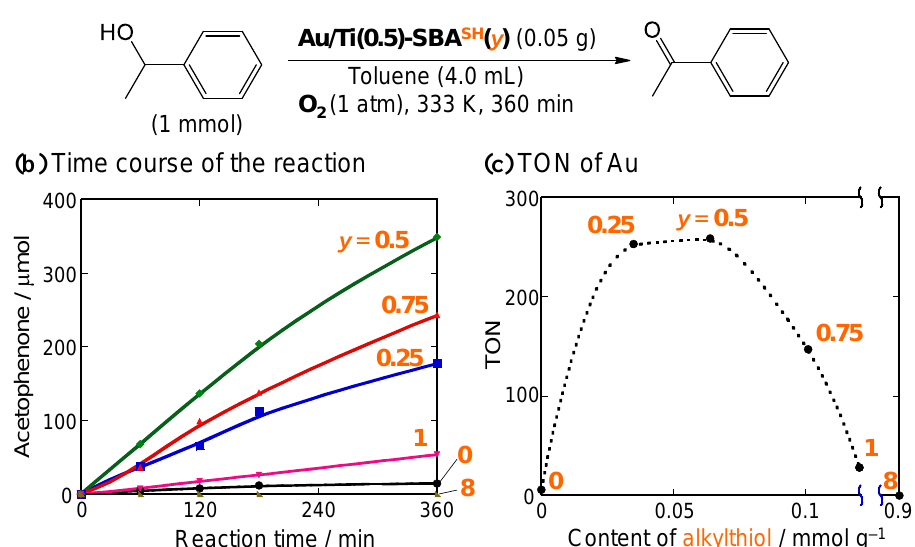
Figure 8. Aerobic oxidation of 1-phenylethanol catalyzed by Au/Ti(0.5)-SBA SH ( y ): ( a ) Reaction condition; ( b ) time course of the reaction; ( c ) content of alkylthiol versus TON of Au.